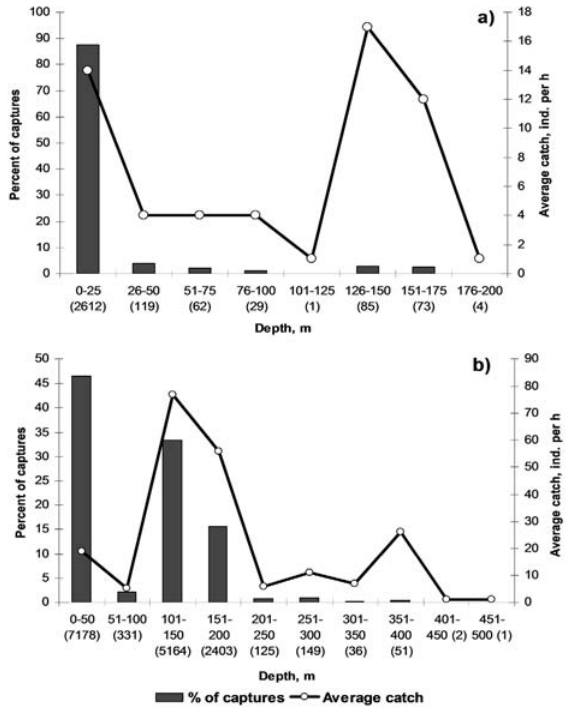
Fig . 5. – Vertical distribution of Squalus suckleyi in the North Pa- cific: (a) in the water column, and (b) near the bottom (number of fish caught within each depth range is shown in brackets).